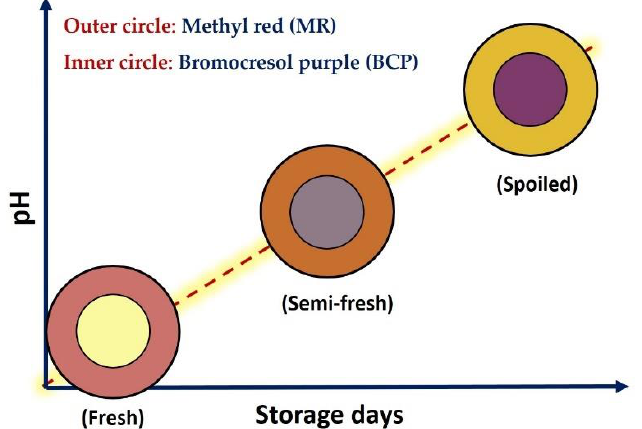
Figure 1. Color design of freshness dual-sensor labels based on the response of methyl red (MR, outer circle) and bromocresol purple (BCP, inner circle) upon pH variation as an indication of fresh, semi-fresh (should be consumed in hours) and spoiled (should not be consumed) chicken breast